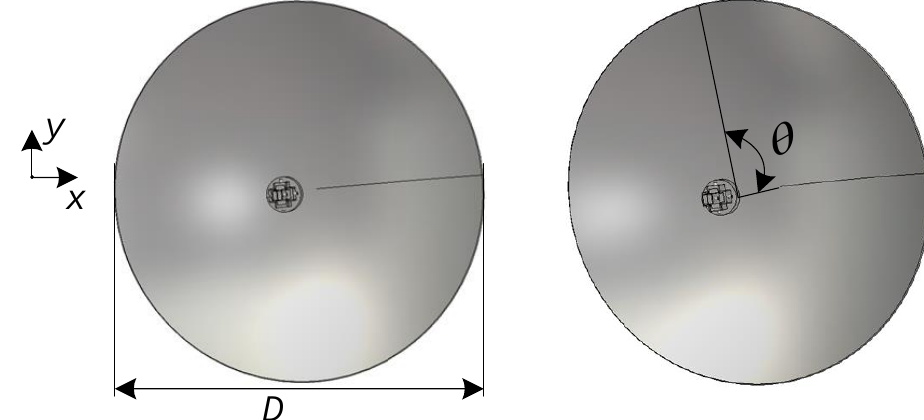
Figure 13. Proposed monopulse reflector antenna. Table 3. Dimensions of the parabolic reflector.